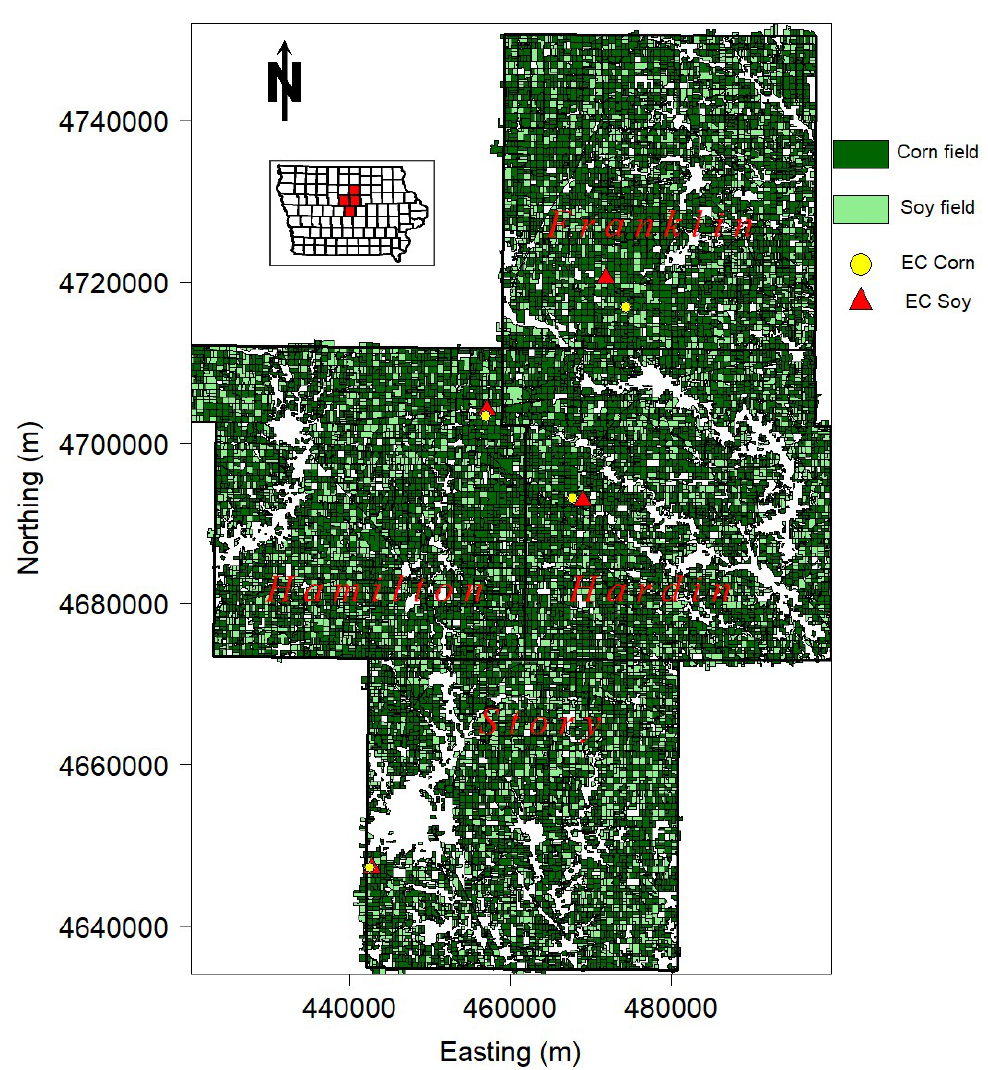
Figure 1. Land use map of four counties in Iowa (red marked counties in small map) in 2016 [18]: Story County (lower), Hamilton County (center left), Hardin County (center right), and Franklin County (upper). Corn fields are marked dark green, and soybean fields are light green (each land use area > 55%). The red triangles and yellow circles show the location of the eddy-covariance (EC) stations in soybean and corn fields, respectively.